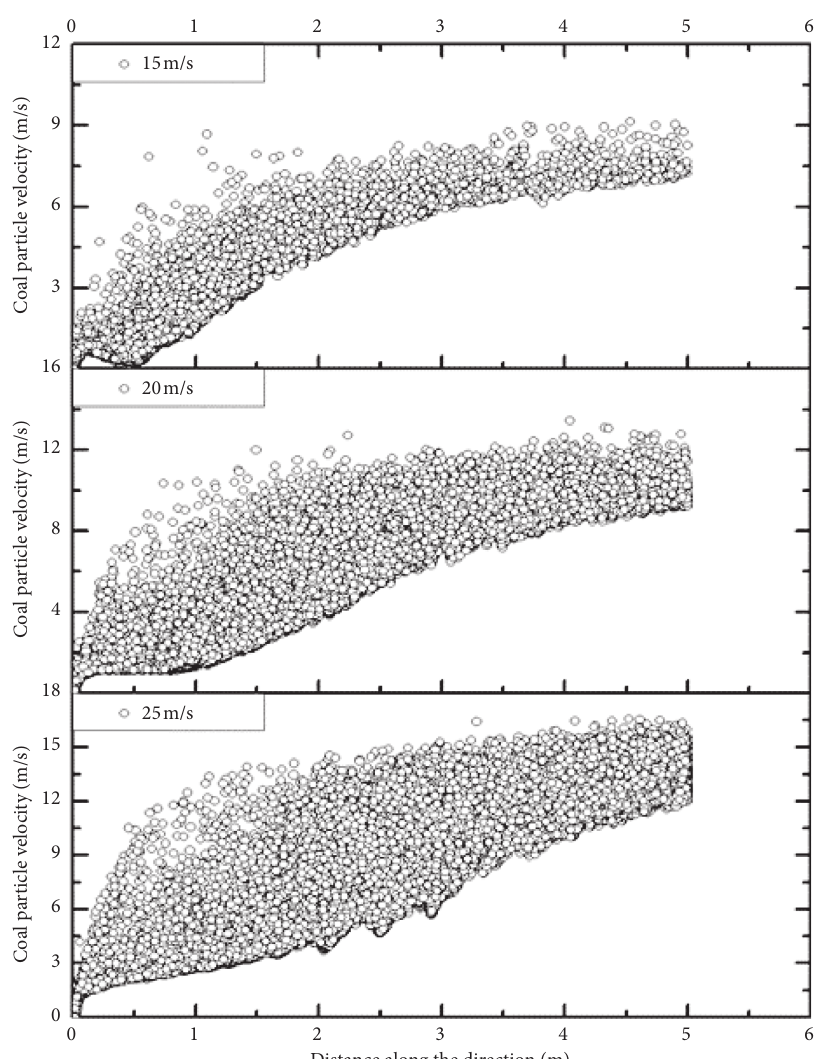
Figure 15: Particle velocity distribution along the flow direction with particle generation rate of 0.05kg/s ( t �